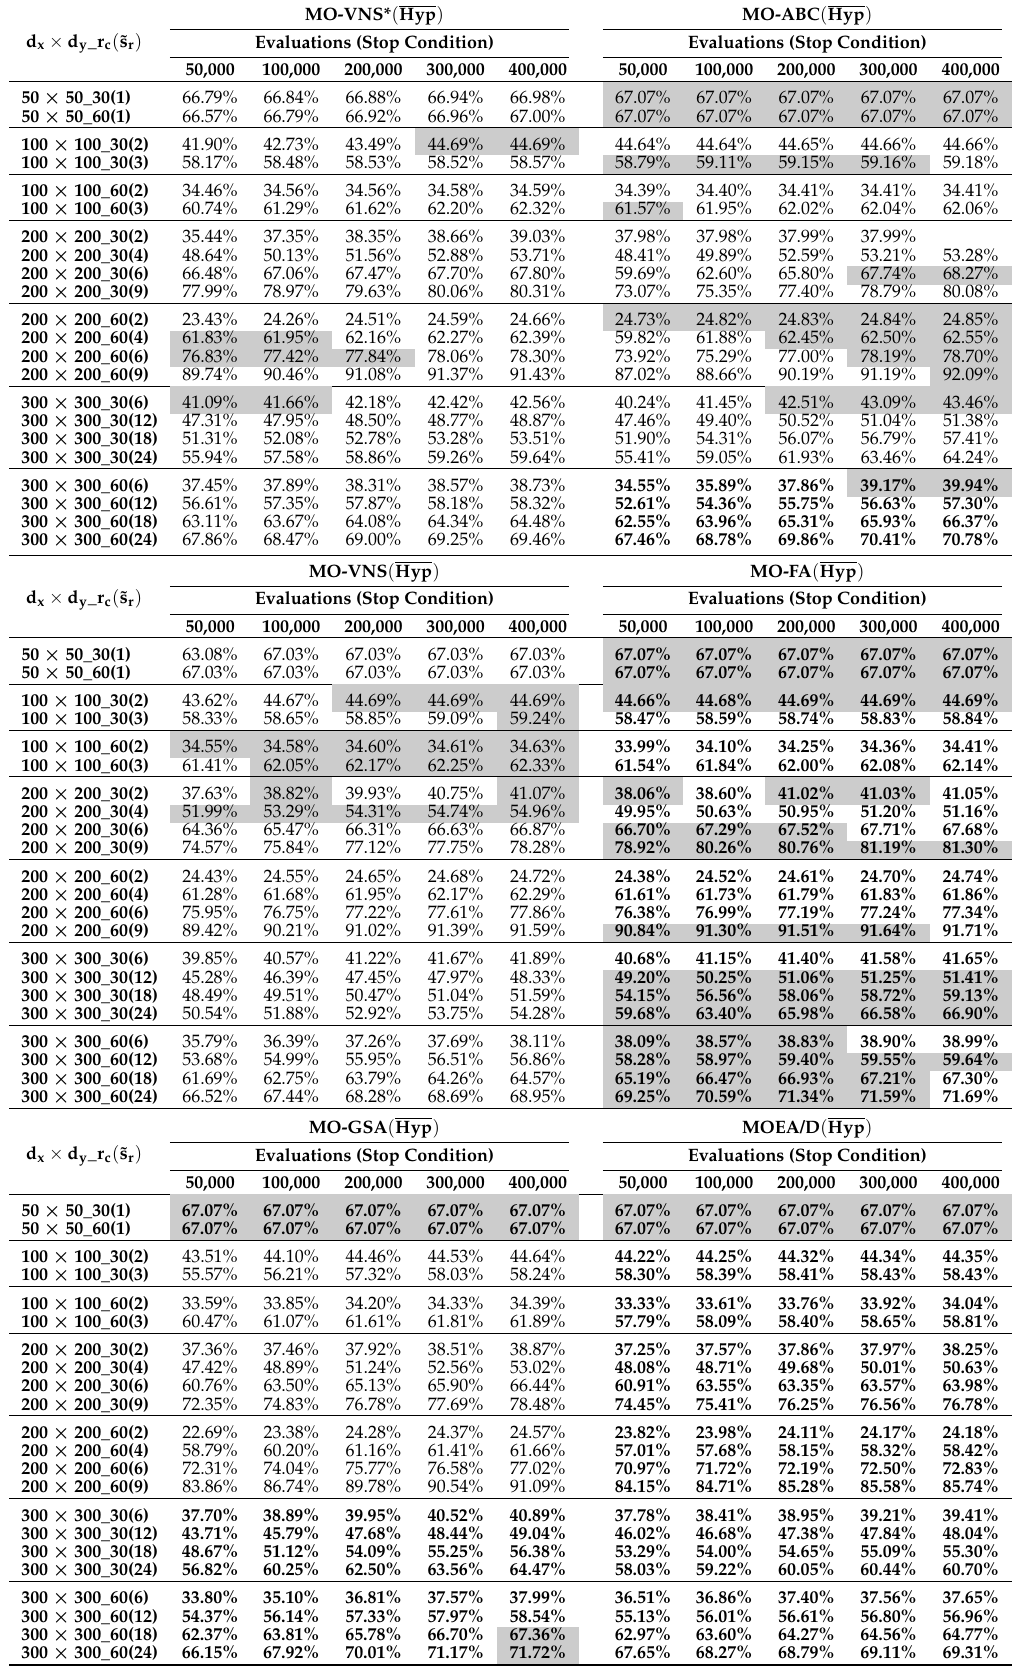
Table 3. Median hypervolume obtained solving the bi-objective